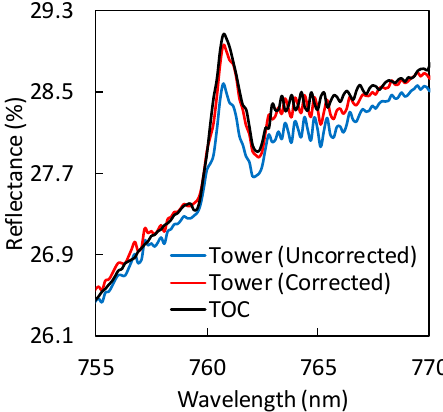
Figure 6. Comparison of the apparent reflectance spectra at O 2 -A band measured on the ground and on the tower (with/without atmospheric correction) at 13:01 on September 7, 2018, at the Daman site.